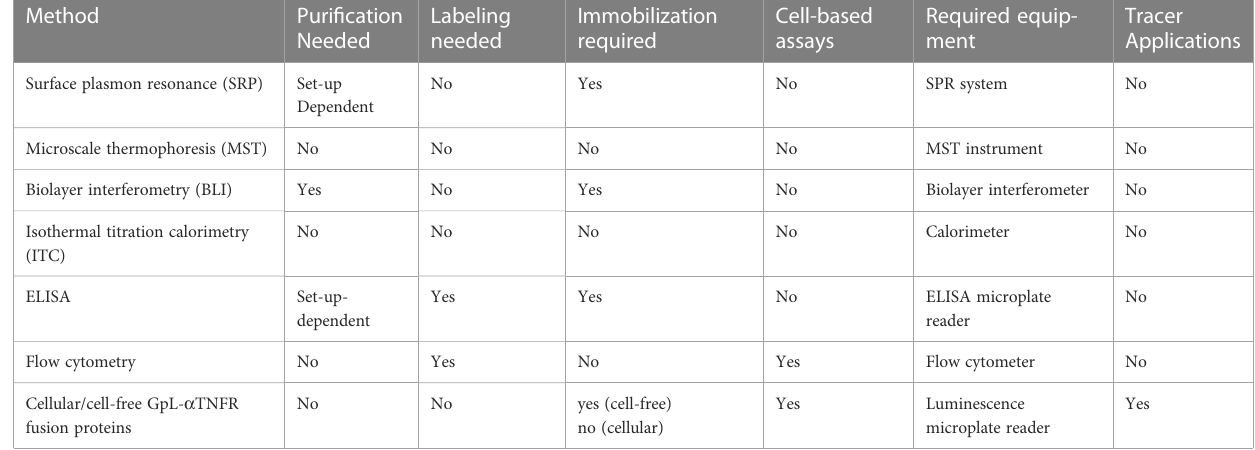
TABLE 2 Methods for the analysis of the interaction of TNFRs with anti-TNFR antibodies and anti-TNFR antibody fusion proteins.